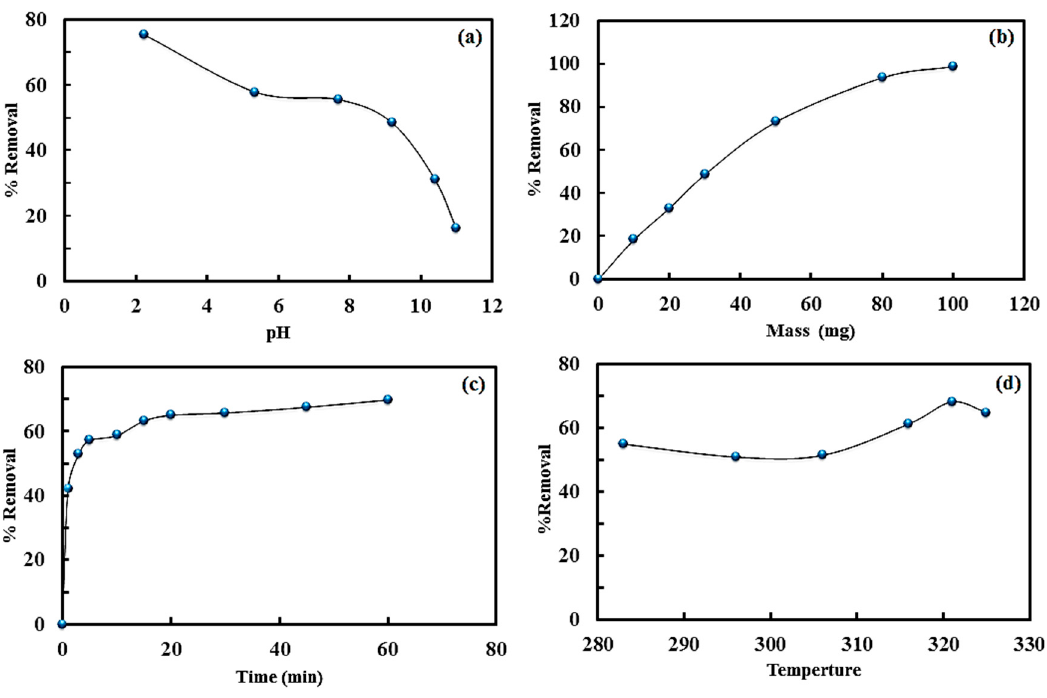
Figure 9. Effect of ( a ) pH, ( b ) PMG50 composite mass, ( c ) contact time, and ( d ) temperature on % adsorption removal of AR1 dye.